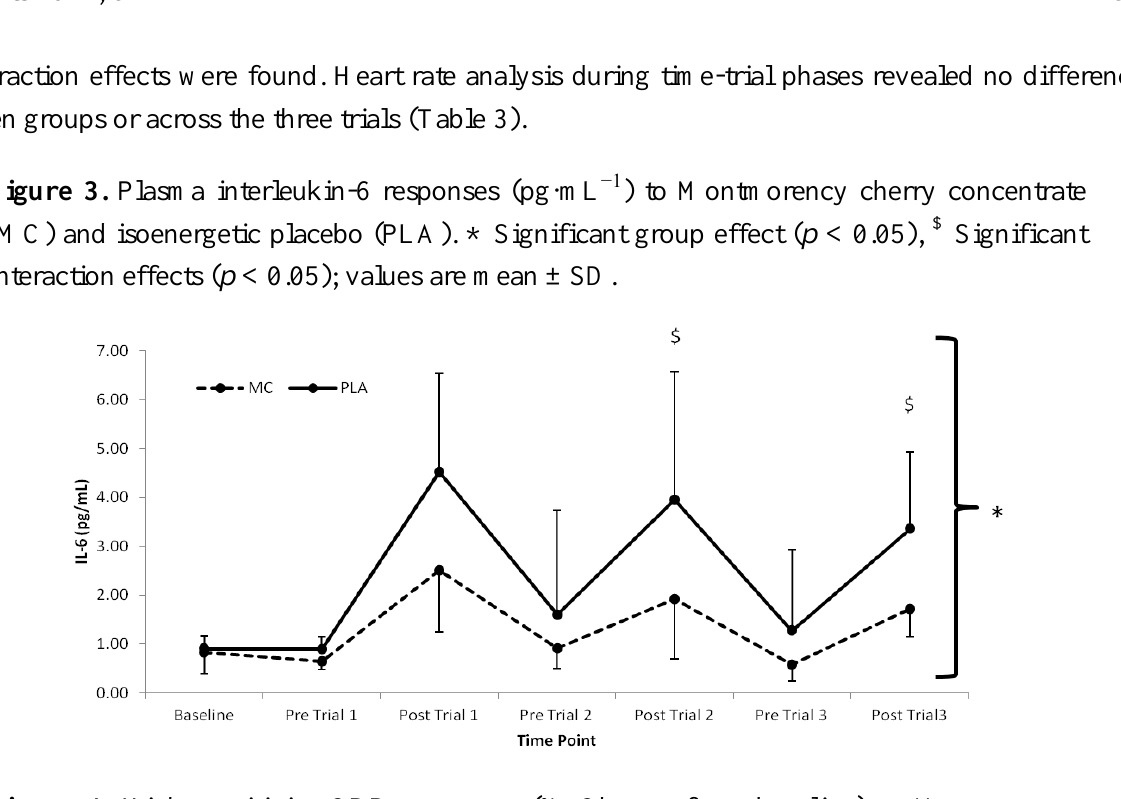
Figure 4. High-sensitivity CRP responses (% Change from baseline) to Montmorency cherry concentrate (MC) and isoenergetic placebo (PLA). Absolute baseline values were 0.889 ± 0.592 and 0.475 ± 0.191 pg·mL −1 for MC and PLA respectively. * Significant group effect ( p < 0.05), $ Significant interaction effects ( p < 0.05); values are mean ±